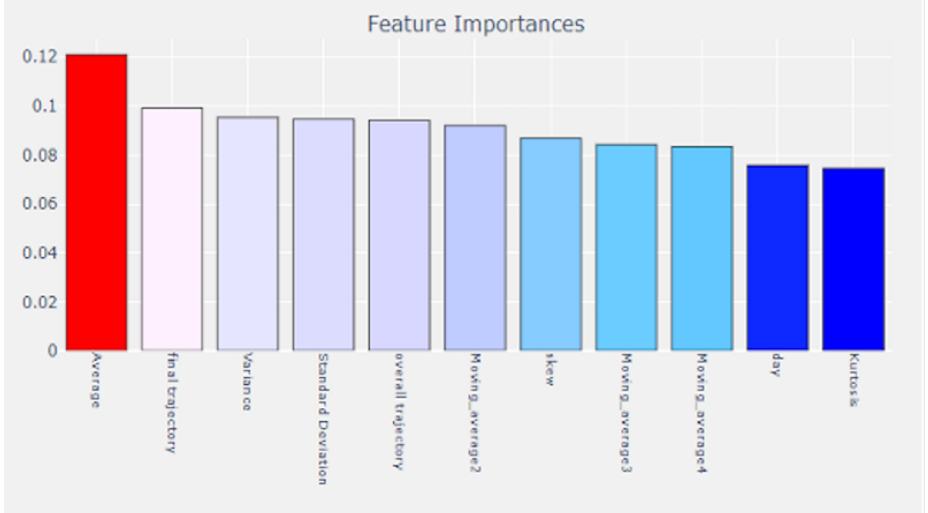
Figure 5. Correlation Matrix of Features.